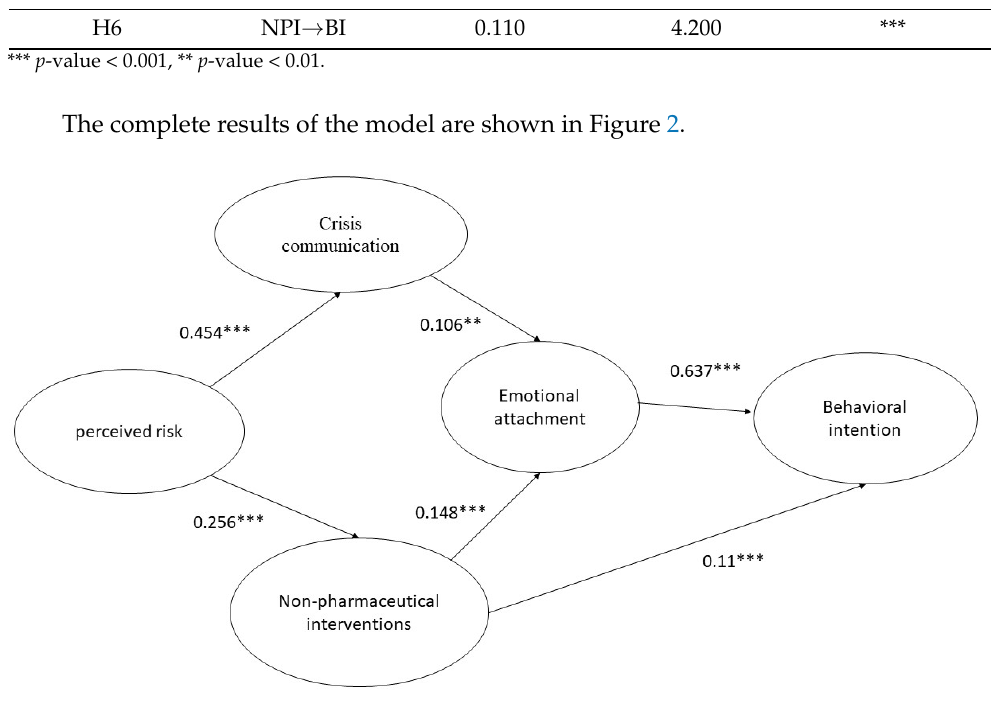
Figure 2. Structural Analysis of Research Model. *** p -value < 0.001, ** p -value < 0.01, * p -value < 0.05.